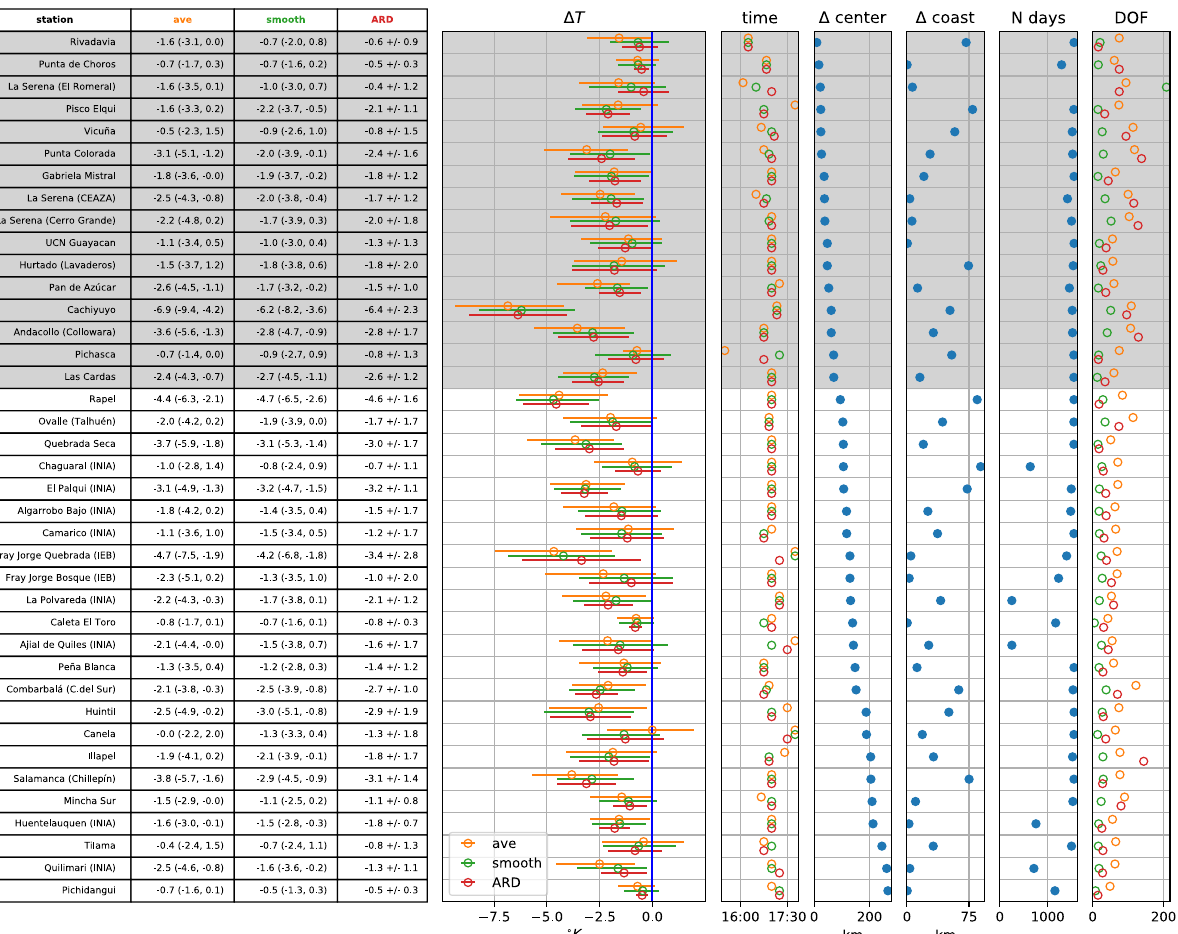
Figure 5. (cid:31) T estimates for stations in the Coquimbo Region with at least 1 year of available data at a resolution of at least 15 min. For lasso regressions (average and smoothing), uncertainties are given as 2.5 and 97.5 percentiles of the test errors separately, while for ARD regression, one value of 1.96 times the standard deviation of the predictive distribution is given. Lasso estimates are corrected for the bias of the error distributions. Errorbars on plots correspond to these ranges. ‘Time’ is the time of maximum (cid:31) T for each type of estimate; ‘ (cid:31) center’ is the distance from a station to the eclipse’s center line; ‘ (cid:31) coast’ the distance to the coast. ‘N days’ is the number of available days on record, and ‘DOF’ are the degrees of freedom (number of regression coefficients) for each